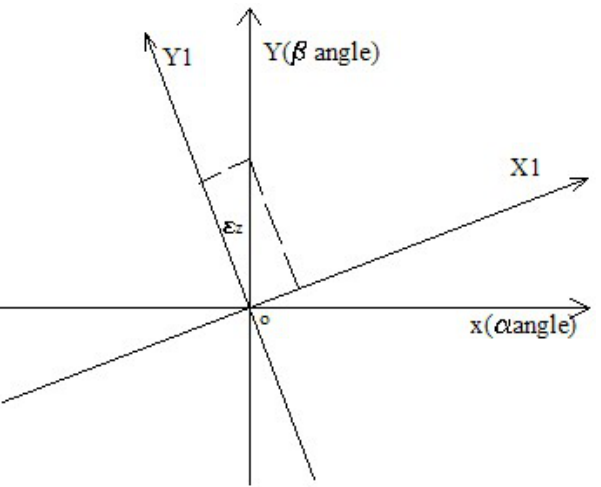
Figure 6. The sketch map of rotation of coordinate